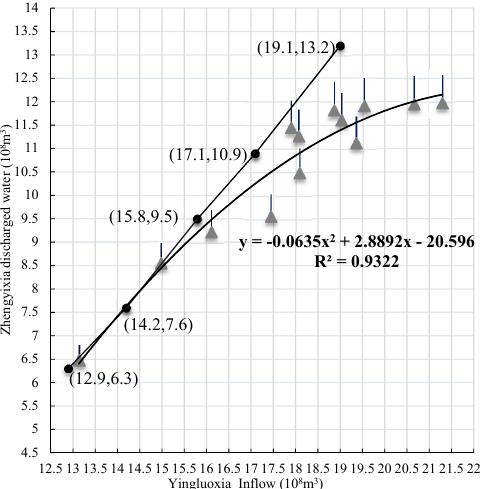
Figure 3. The relationship curve for water reallocation targets of the ‘97’ water diversion plan and the improved plan. Note: The straight line is the runo ff relationship of the original plan. The black solid points are the reallocation targets of the original plan corresponding to di ff erent Yingluoxia inflow levels and the gray solid points are the actual data allowing for the presence of a 5% relative